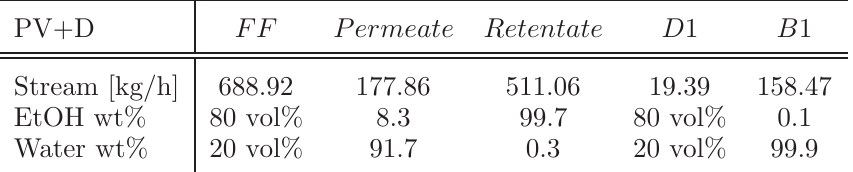
Table 3 Technological streams of adiabatic pervaporation, PV+D.